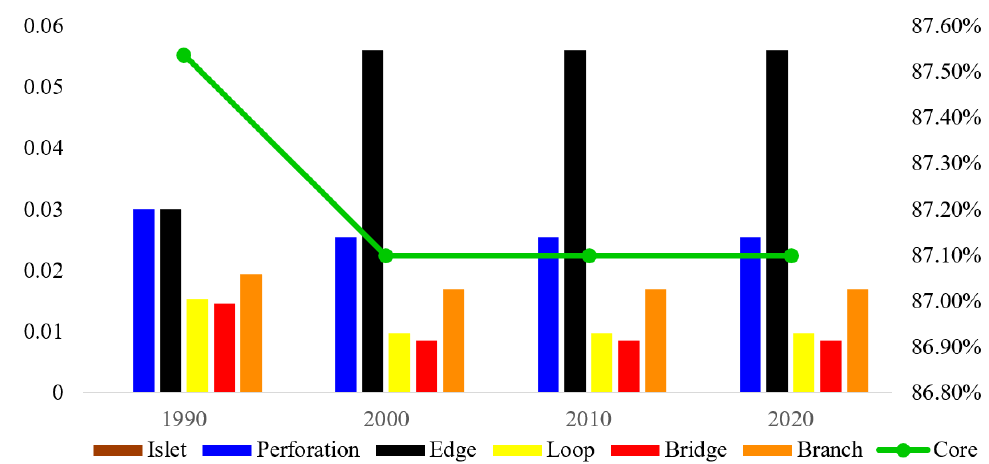
Figure 5. Changes in the proportion of MSPA landscapes in the total prospective area from 1990 to 2020.